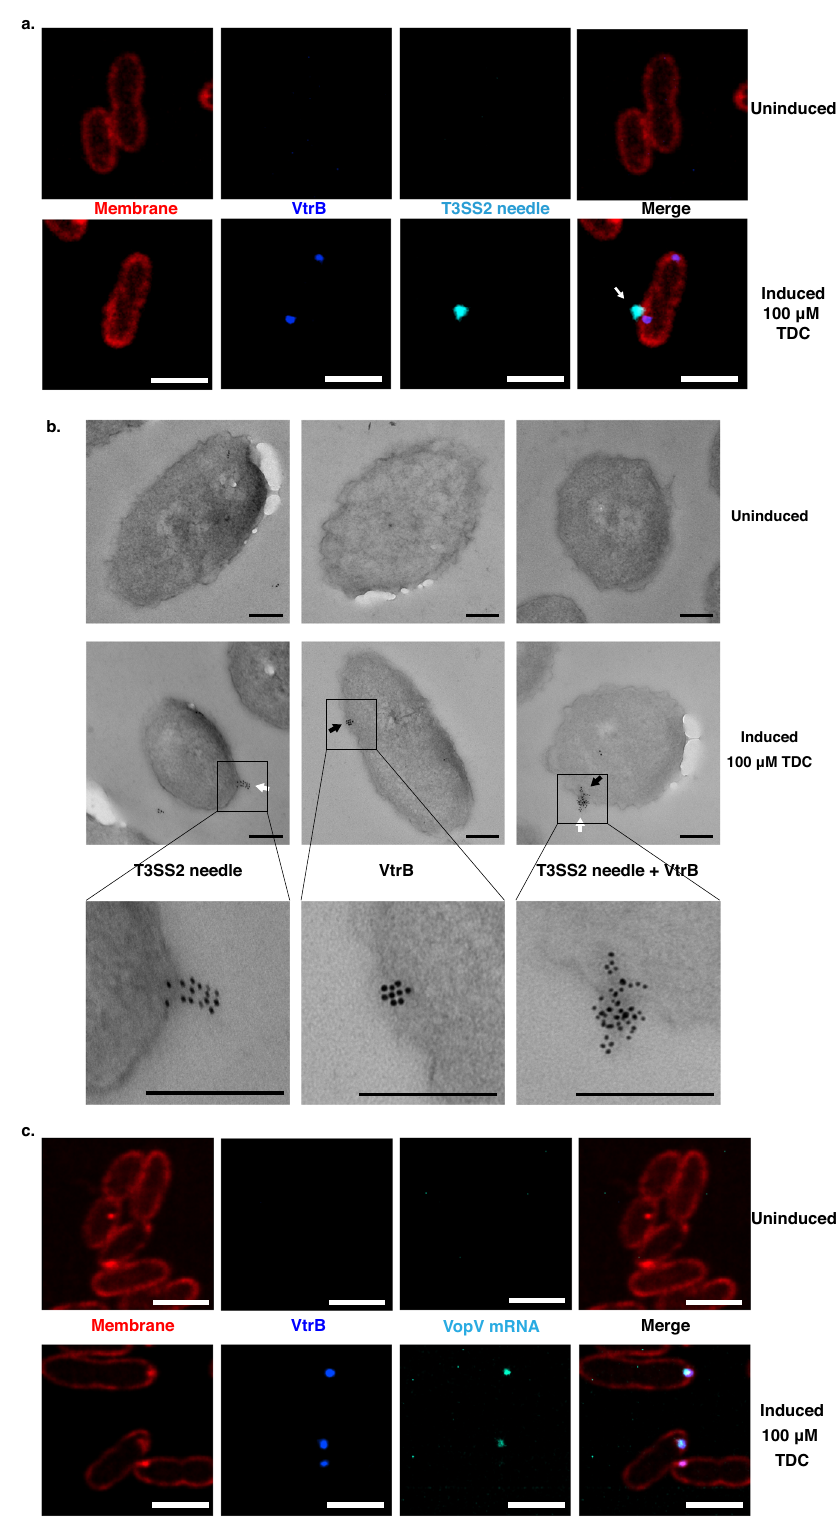
Fig.4|T3SS2effectorsaretranscribedintheimmediatevicinityofVtrBandthe T3SS2 apparatus. a Confocal micrographs of V. parahaemolyticus SC288 cells cultured in inducing (100 µ M TDC) and non-inducing conditions, displaying colo- calizationofVtrB(false-coloredblue)withT3SS2needles(false-coloredcyan)atthe membrane (red). White arrow points to T3SS2 needle. b Transmission electron micrographs of VPKK12 cells grown in either non-inducing or inducing (100 µ M TDC) conditions. Thin-sectioned samples were stained with anti-GFP (1:1500) mouse and anti-Vpa1343 (1:500) rabbit primary antibodies, and counterstained